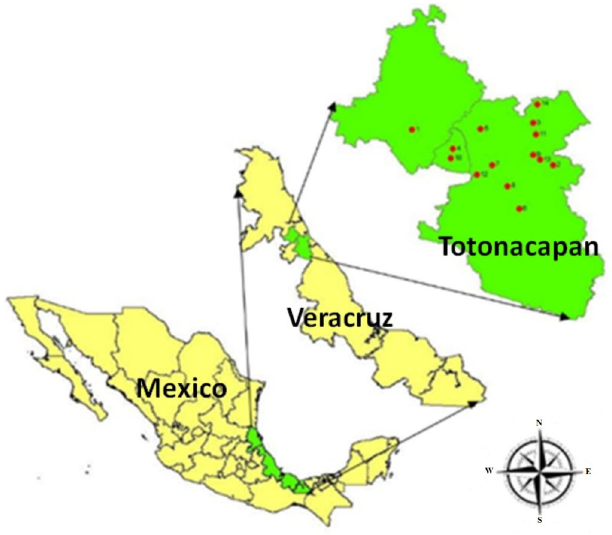
Figure 3. Study area of Veracruz, Mexico.